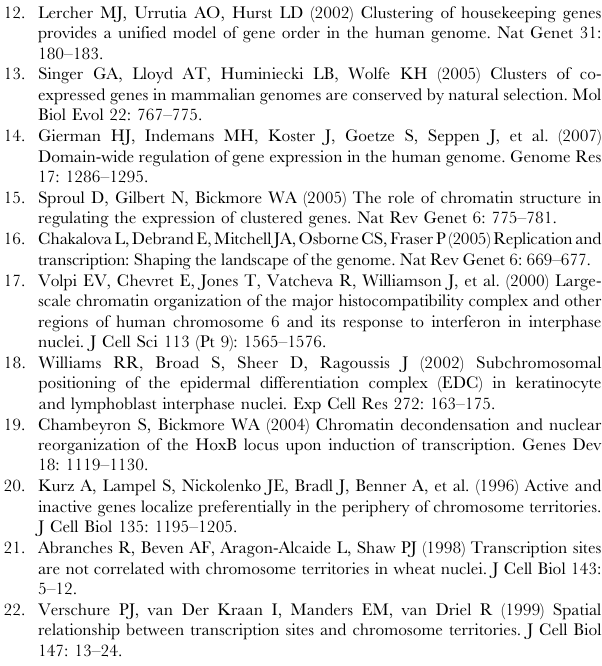
Figure S1 Primary transcript levels of genes at 8C3/C4 Found at: doi:10.1371/journal.pgen.1000016.s001 (1.79 MB EPS) Figure S2 Insertion of the LCR has no effect on the association of 8C3/C4 with splicing speckles Table S1 Primers and